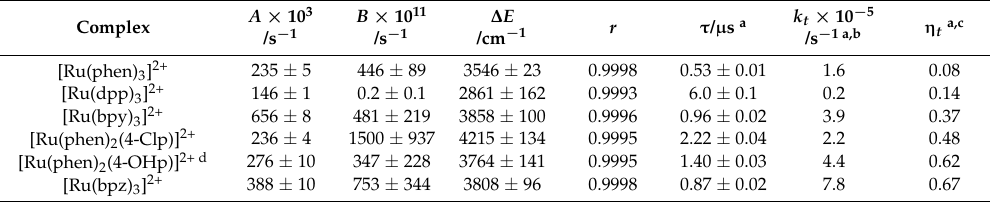
Table 1. Kinetic parameters for the 3 MLCT excited state deactivation of the investigated Ru(II) complexes in deoxygenated propylene carbonate, obtained from fitting the experimental emission lifetime data as a function of temperature to Equation (1) (see